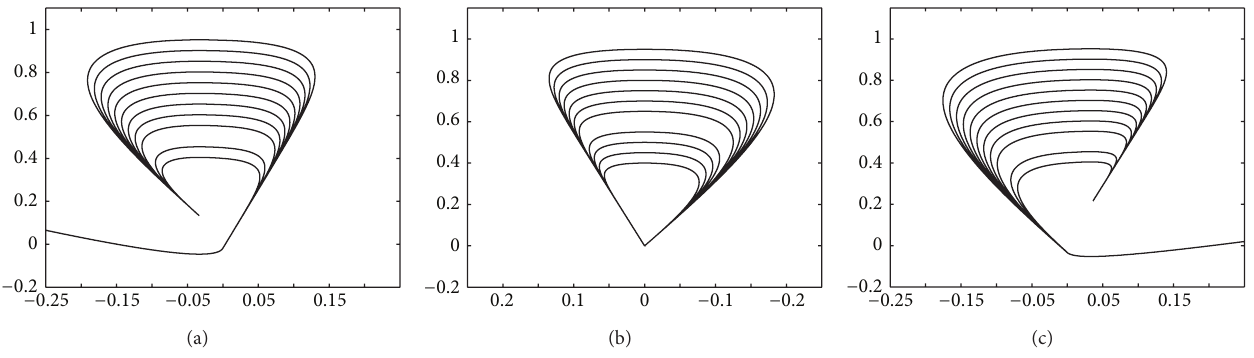
Figure 10: Discontinuity induced homoclinic bifurcation in the degenerate